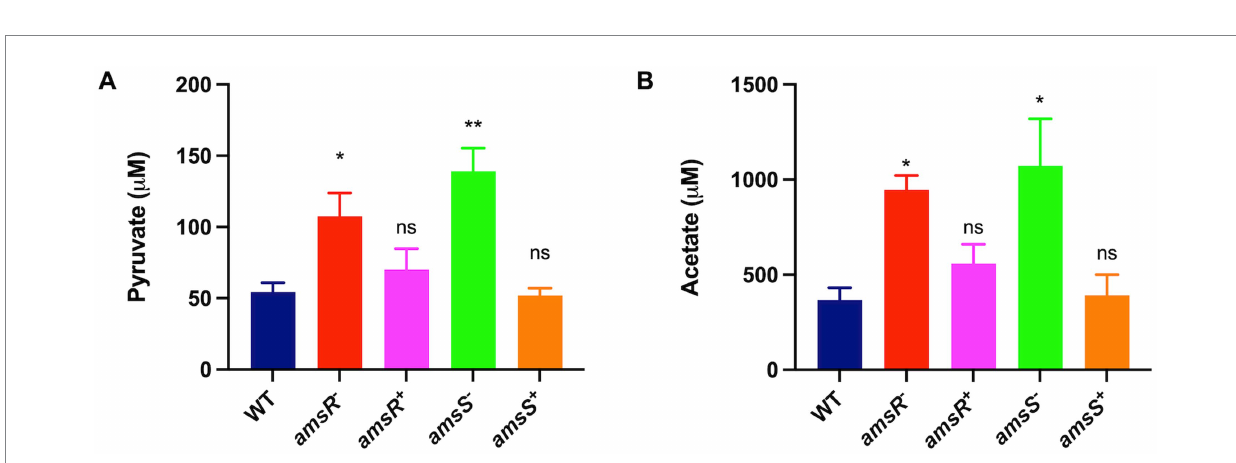
FIGURE 7 Increased pyruvate in the amsR and amsS mutant strains lead to a glyoxylate shunt that favors acetate production. Intracellular levels of pyruvate (A) or acetate (B) were measured in exponentially growing cells. Data is derived from three independent biological replicates. Error bars ± SEM. One-way analysis of variance, with Dunnett’s multiple-comparisons test, was used to assess statistical significance in comparison to wild-type, * p < 0.05, ** p < 0.01, ns, not